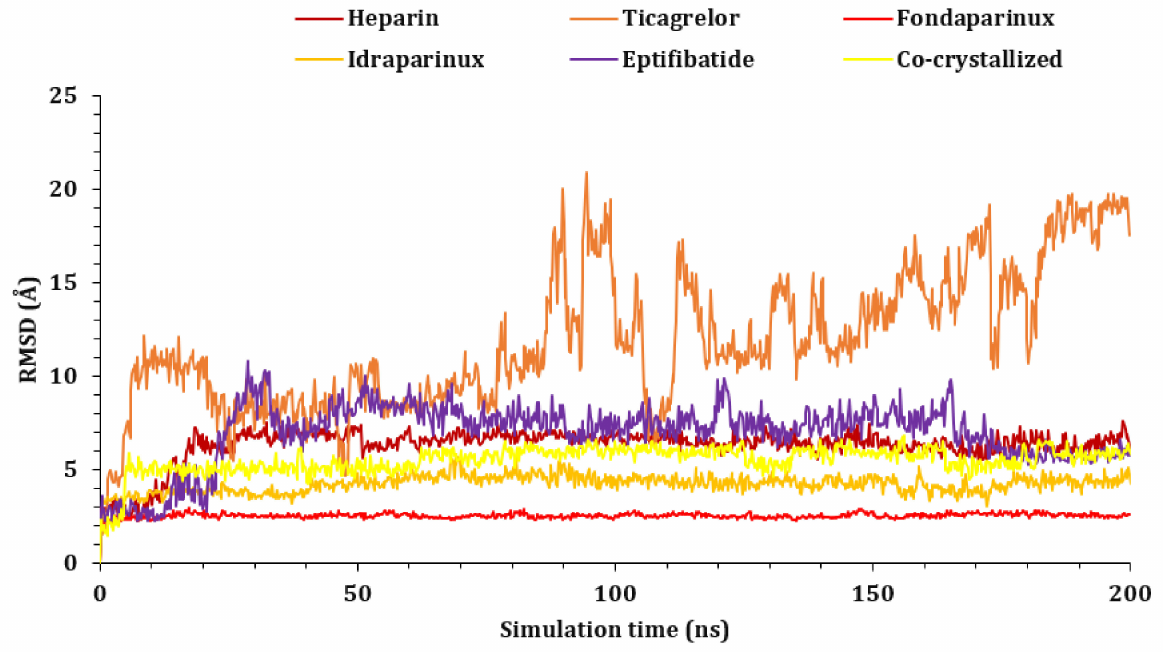
Figure 4. The RMSDs of ligand complexes (heparin, ticagrelor, fondaparinux, idraparinux, eptifi- batide, and O6K-6Y2G, respectively) during the simulation time (200 ns).